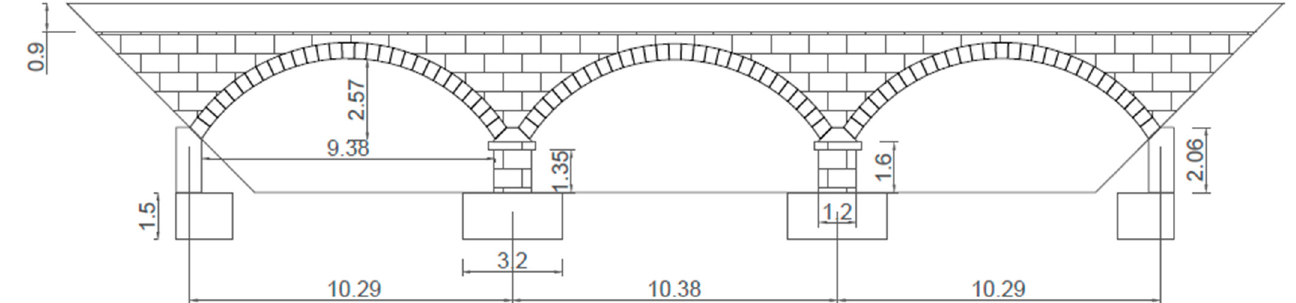
Figure 2. Case study (dimensions in m).